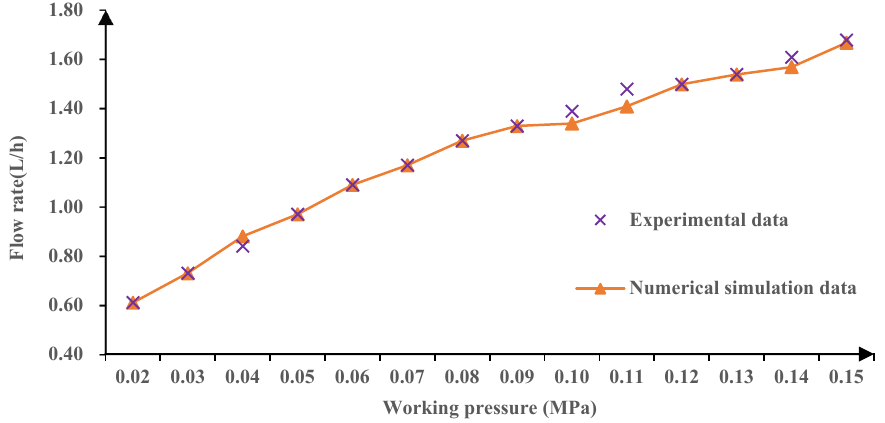
Figure 12. Hydraulic characteristic curves of the practical experiment and numerical simulations with NO.5 drip irrigation tape.